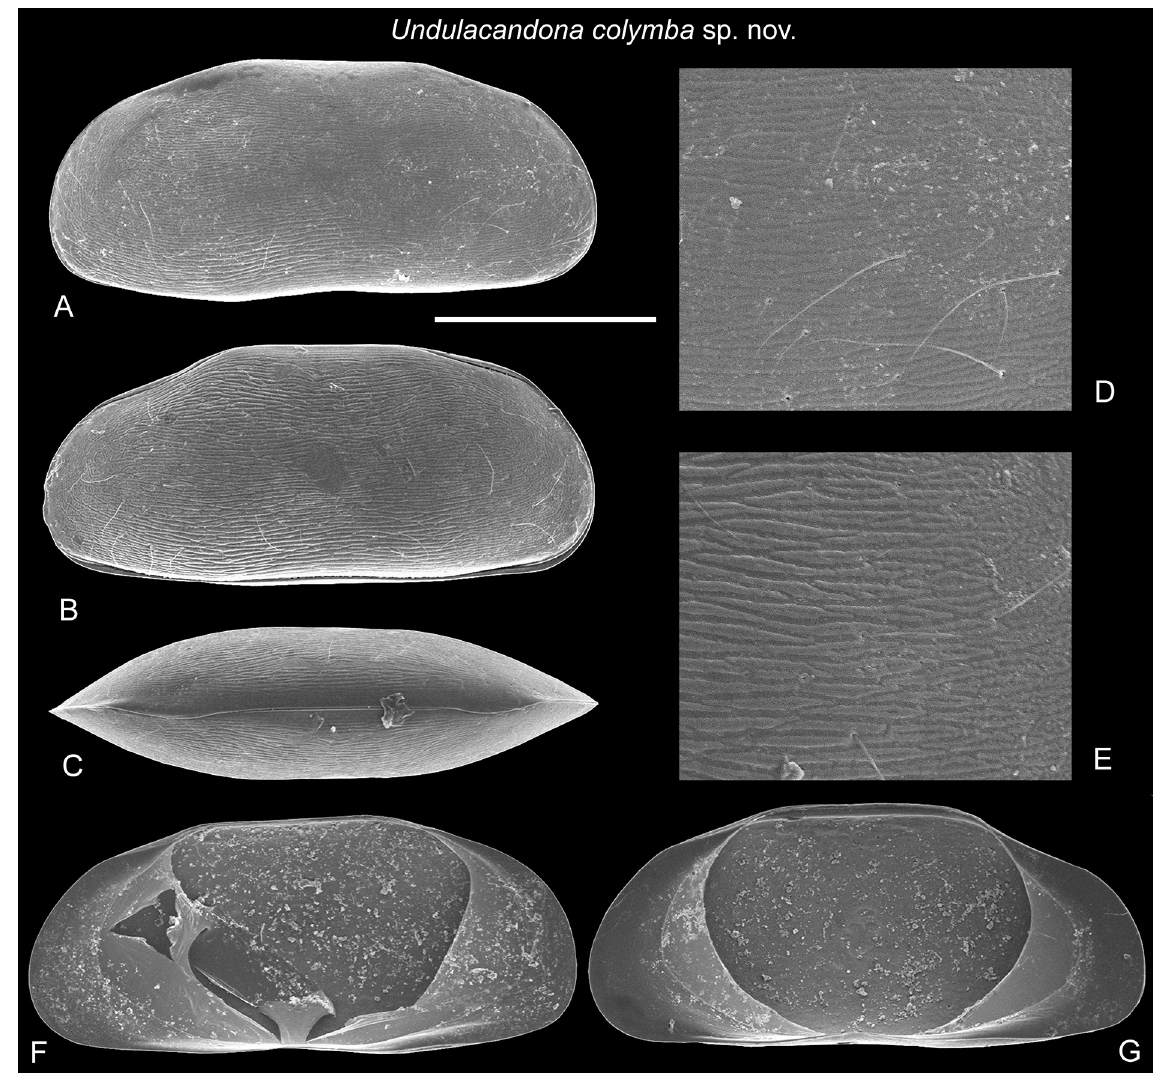
Fig. 14. Undulacandona colymba sp. nov. A . External view of male right valve (LBM 1430006283). B . Right view of female carapace (LBM 1430006284). C . Dorsal view of female carapace, anterior to right (LBM 1430006284). D . Detail of external surface of male right valve (LBM 1430006283). E . Detail of external surface of female right valve (LBM 1430006284). F . Internal view of male right valve (LBM 1430006283). G . Internal view of female right valve. Scale bar: A–C, F–G = 300 µm; D–E = 87